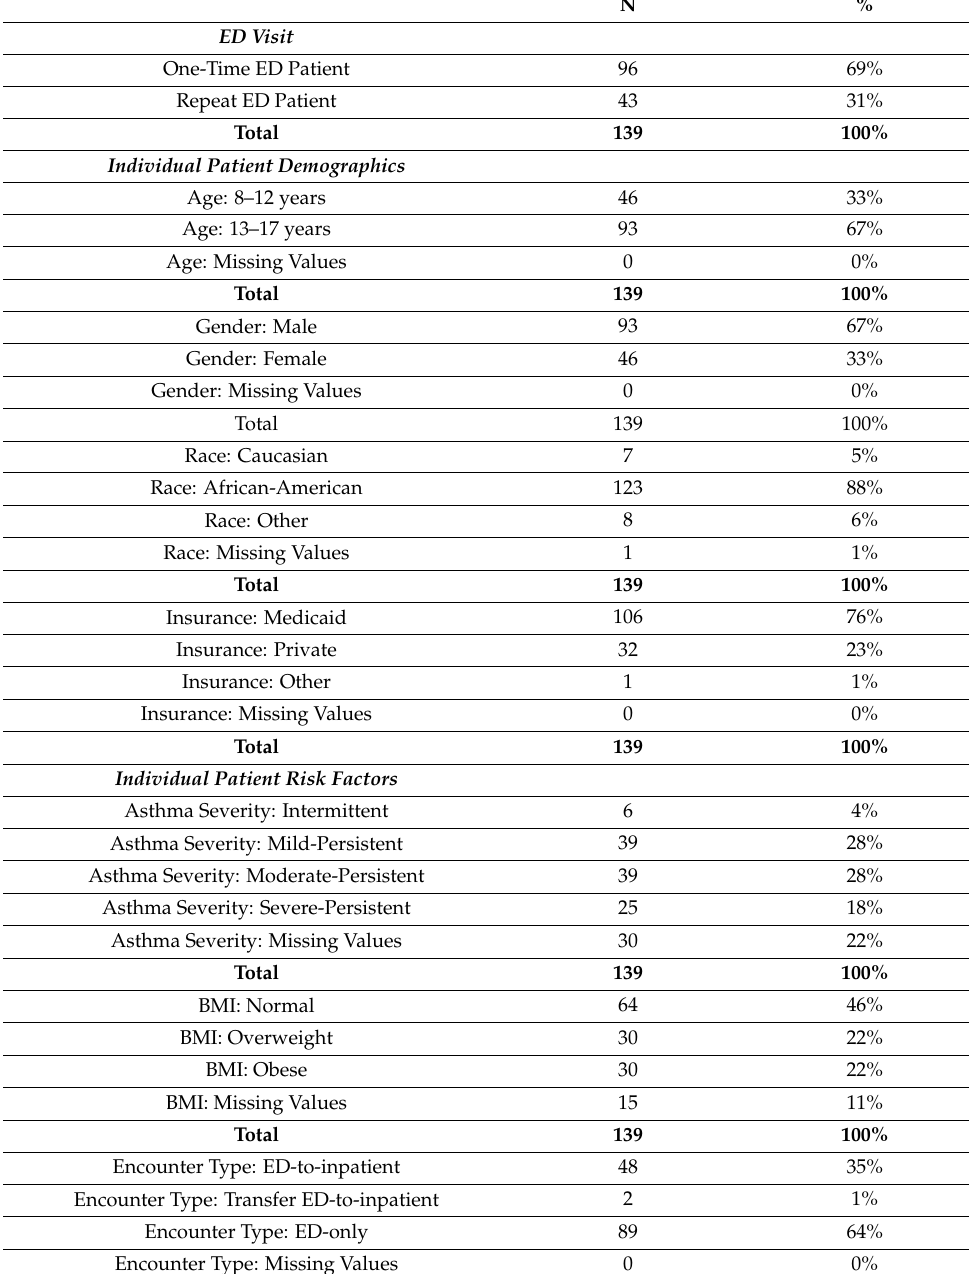
Table 2. Summary data on study variables: Round 2 analysis (8–17